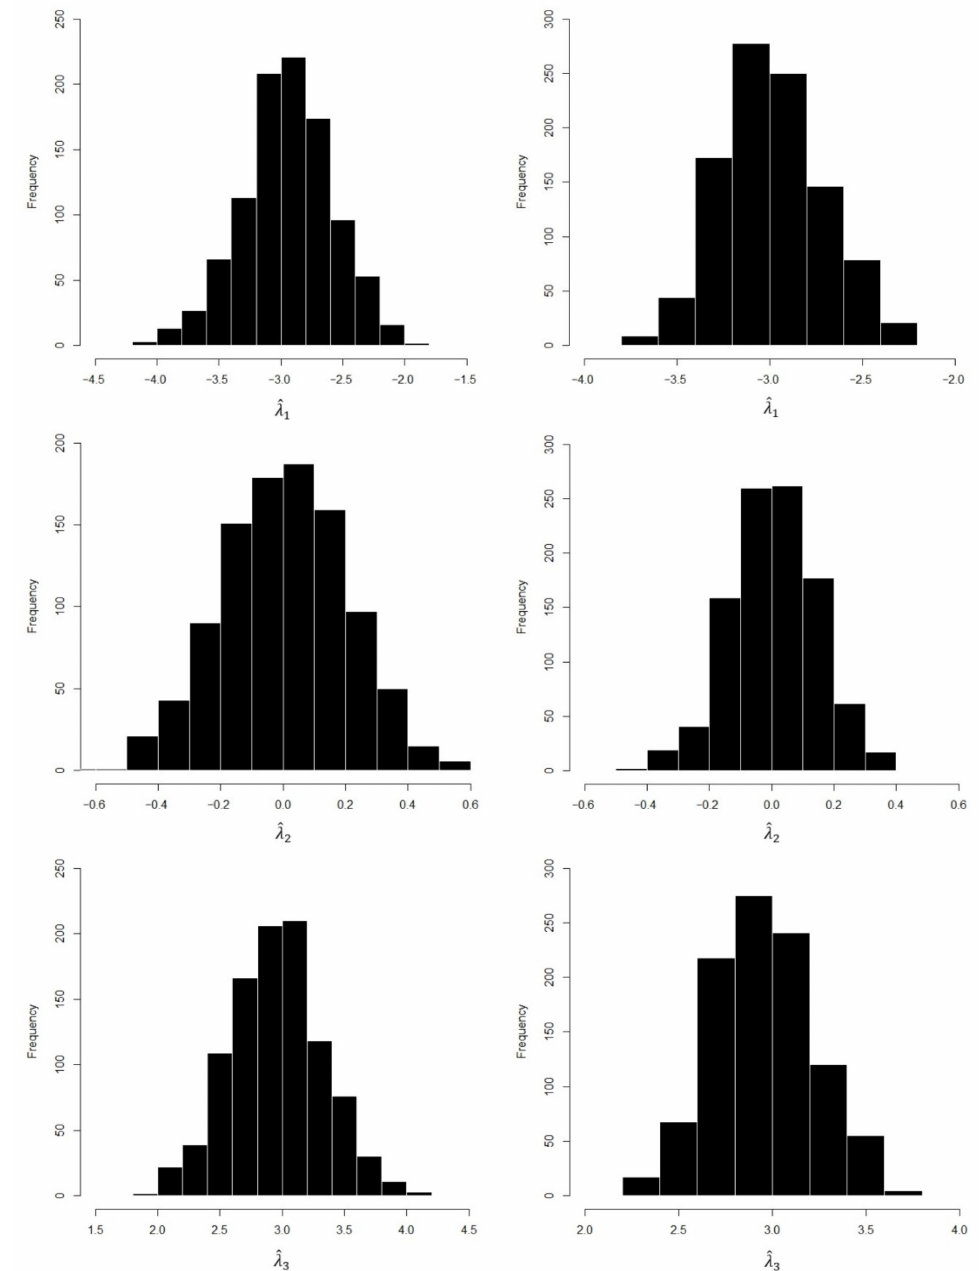
= 0.8 2 and σ 2 = 0.9 2 . The left 1